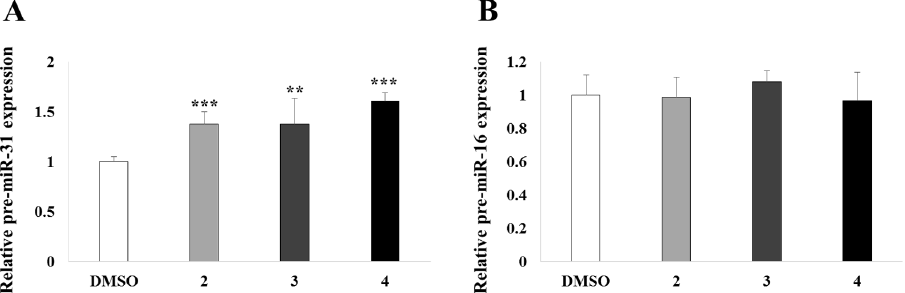
Fig 6. Expression of precursor miR-31 and miR-16. A549 cells were treated with compounds2, 3, and 4, and total RNAs were extracted to detect the expressionof pre-miR-31(A) and pre-miR-16 (B). Ct values for all samples were normalized against RNU6B .Values represent mean ± SD. ** , p < 0.01; *** , p < 0.001 (Student’s t -test) comparedwith expressionin DMSO-treated cells.